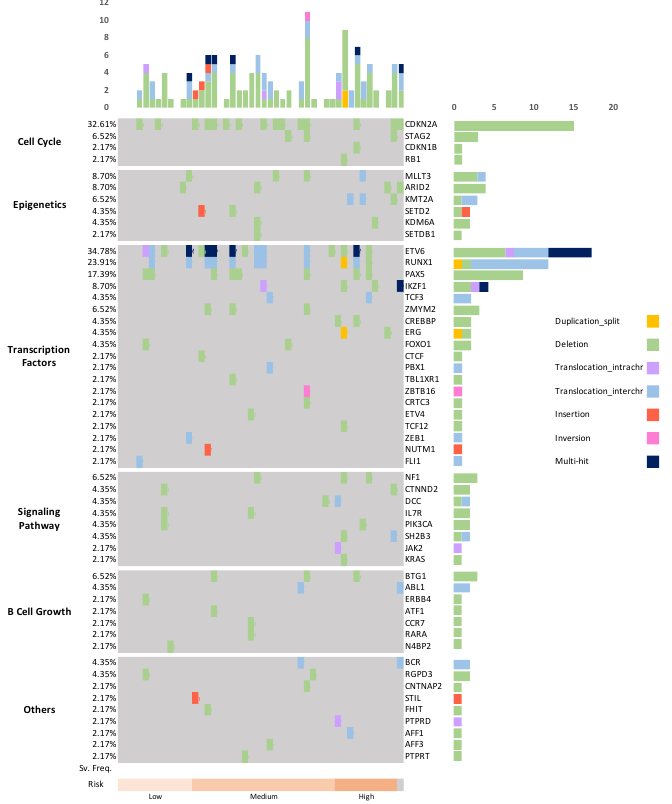
Figure A1. An overview of the genome-wide alterations identified by OGM in 46 pediatric B-ALL samples. The samples are sorted into 3 risk groups, as indicated at the bottom of the panel. The relative mutation frequencies (SV. Freq.) of the genes in different biological processes are indicated on the left. Gene names and types of mutation are shown on the right. The numbers of mutations are shown at the top in a bar plot. The types of mutations are highlighted in different colors.